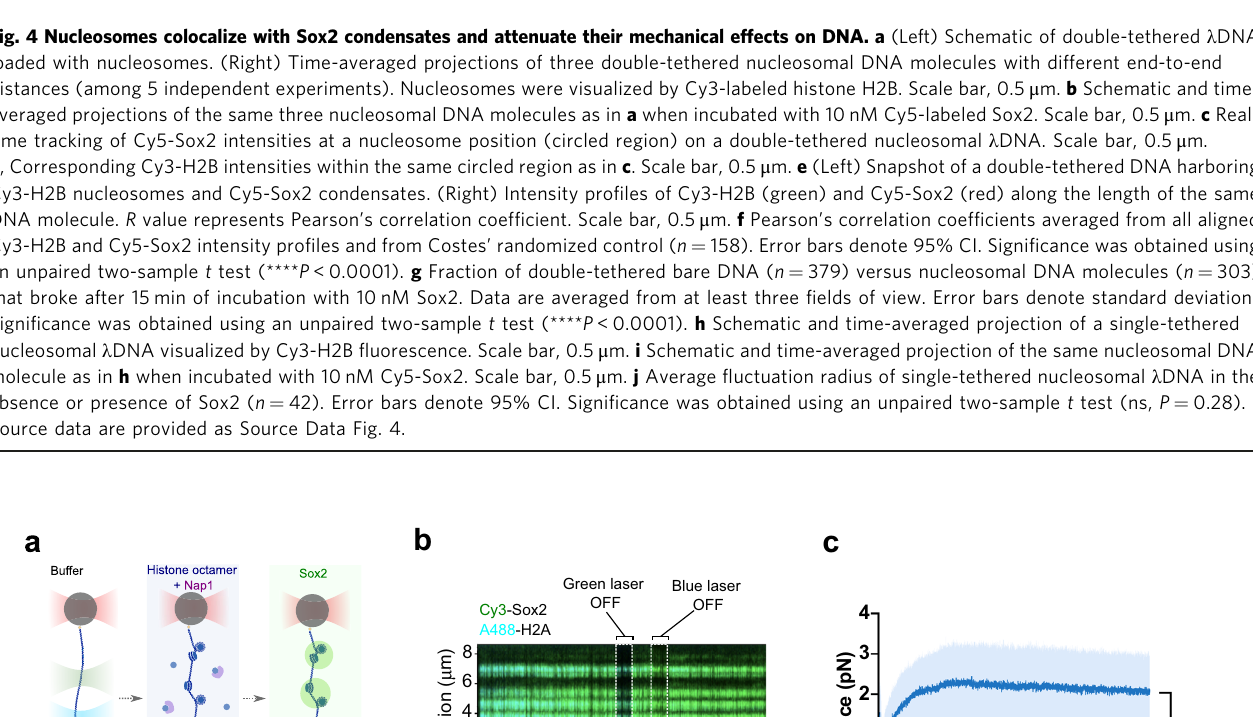
Fig. 5 Nucleosomes attenuate the condensation force exerted by Sox2 on DNA. a Schematic of in situ nucleosome assembly and Sox2 condensate formation on a λ DNA tether in an optical tweezers assay. b A representative kymograph showing the colocalization of Sox2 condensates (green) with nucleosomes (cyan) on a λ DNA tether. c Force measurements on nucleosomal DNA as a function of time (green line) for the assay depicted in a . Data are averaged from 7 representative tethers. Force measurements on bare DNA tethers are shown in blue (averaged from 14 tethers). The dark colored lines correspond to average force trajectories. The shades correspond to standard deviation. The Sox2 concentration in these experiments was 75 nM.